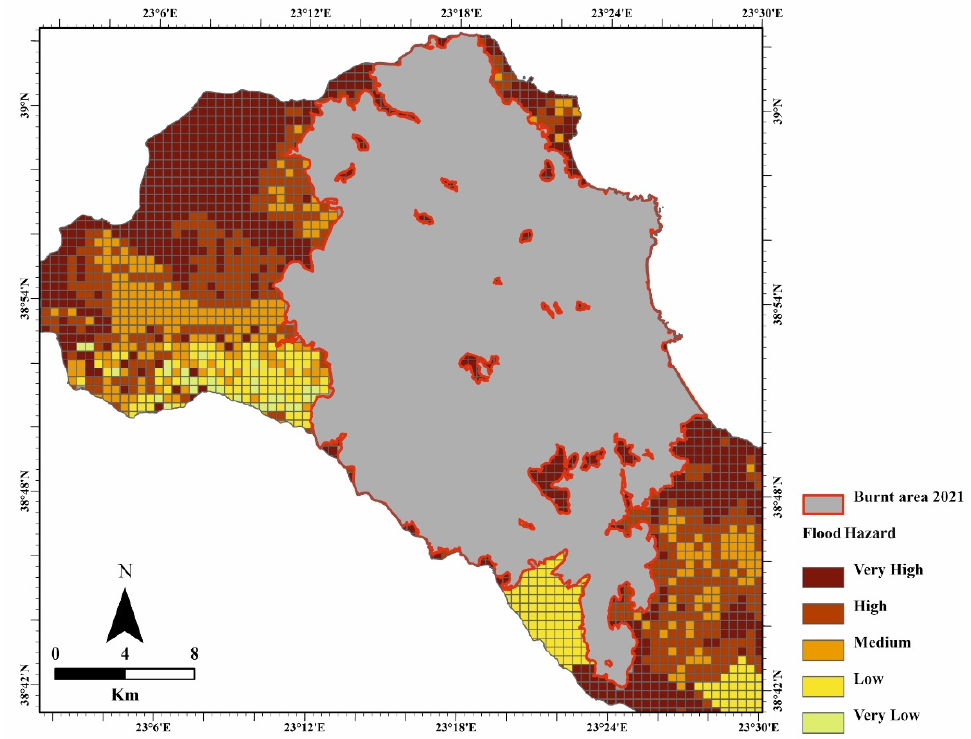
Figure 12. Flash flood hazard in the fire-affected area of northern Euboea using a Boolean logic- based